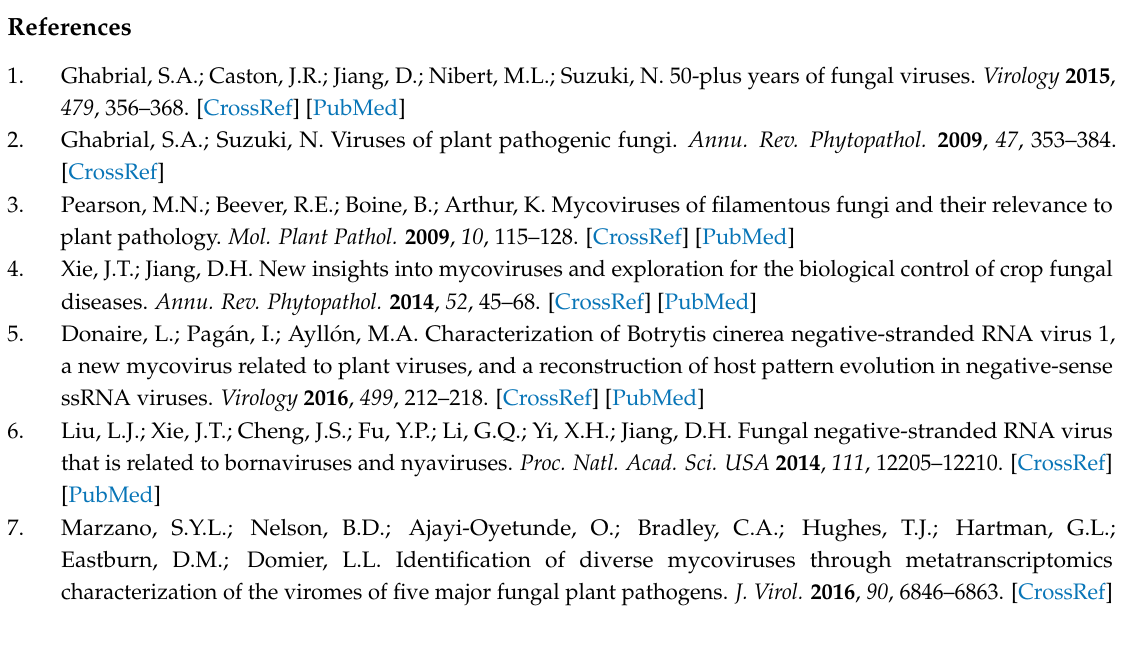
botybirnavirus 1 strain BdEW220. Table S3: PMF-MS analysis of p80 encoded by ORF1 of Bipolaris maydis